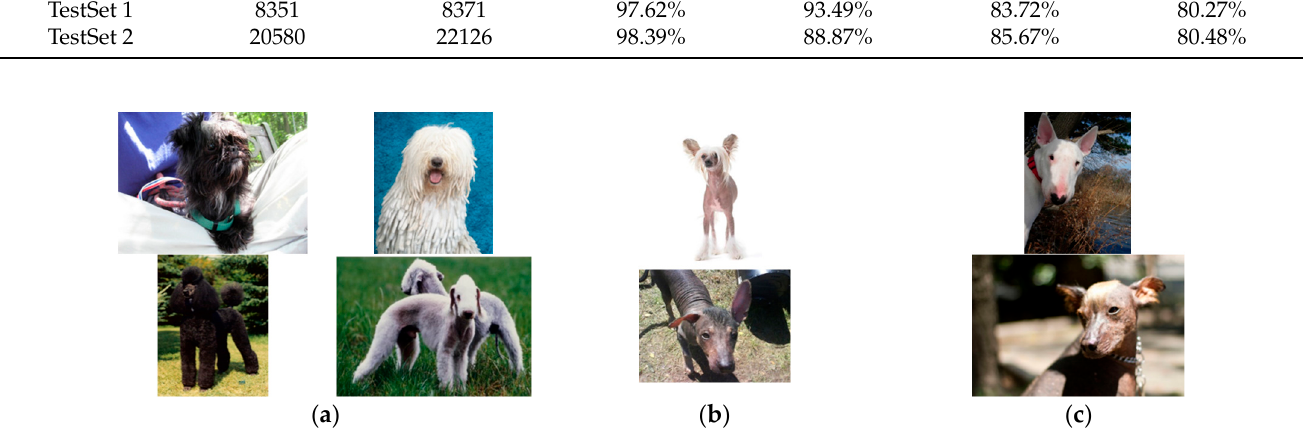
Figure 13. Reason for detection errors in TestSet1 data-set experiment. ( a ) Obscured facial features; ( b ) Special breed of dog; ( c ) Obscured or cropped body.